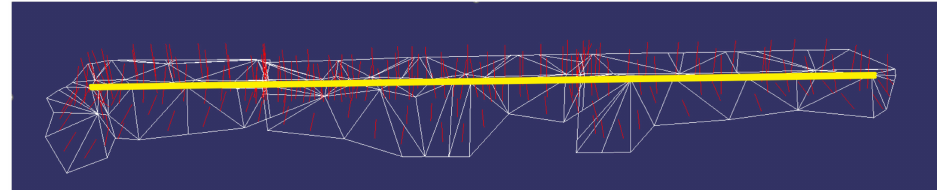
Figure 3. Local triangle vector